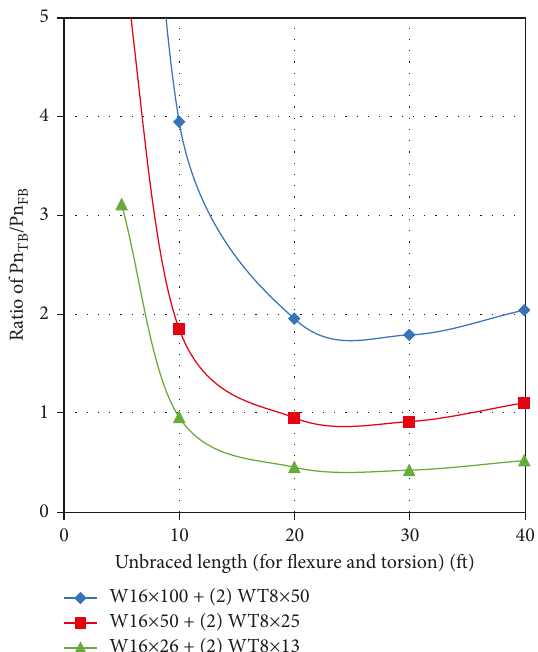
Figure 3: Torsional to flexural buckling ratio for select flanged cruciform members (1ft (cid:30)